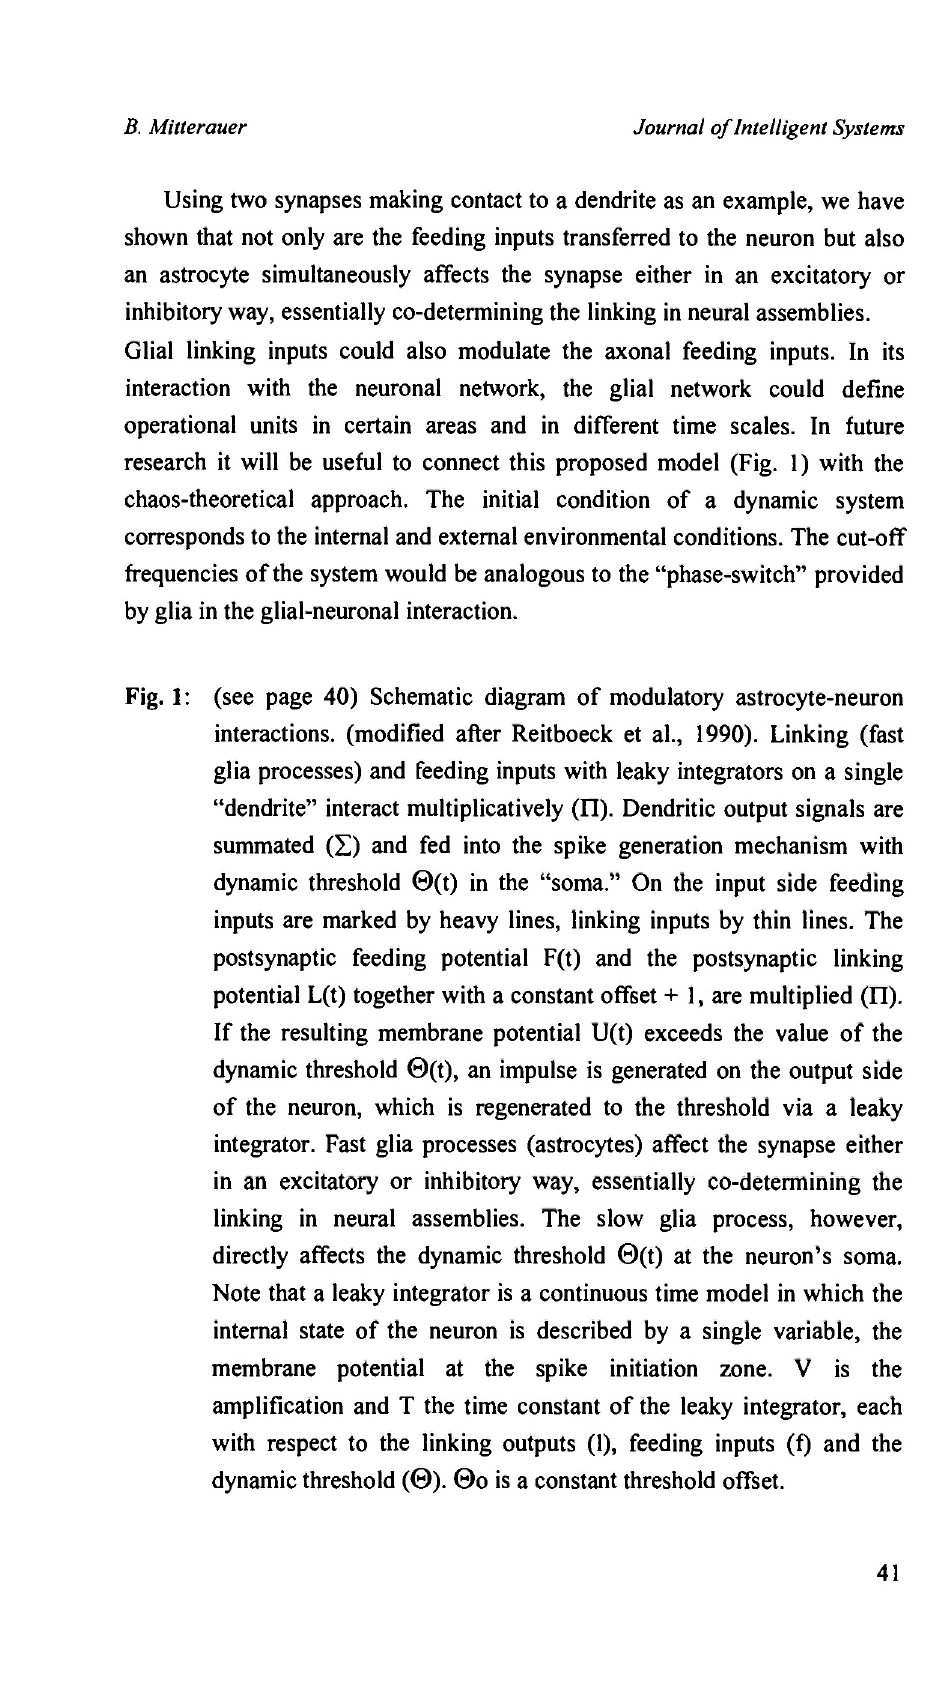
Fig. 1: (see page 40) Schematic diagram of modulatory astrocyte-neuron interactions, (modified after Reitboeck et al., 1990). Linking (fast glia processes) and feeding inputs with leaky integrators on a single "dendrite" interact multiplicatively (Π). Dendritic output signals are summated (Σ) and fed into the spike generation mechanism with dynamic threshold 0(t) in the "soma." On the input side feeding inputs are marked by heavy lines, linking inputs by thin lines. The postsynaptic feeding potential F(t) and the postsynaptic linking potential L(t) together with a constant offset + 1, are multiplied